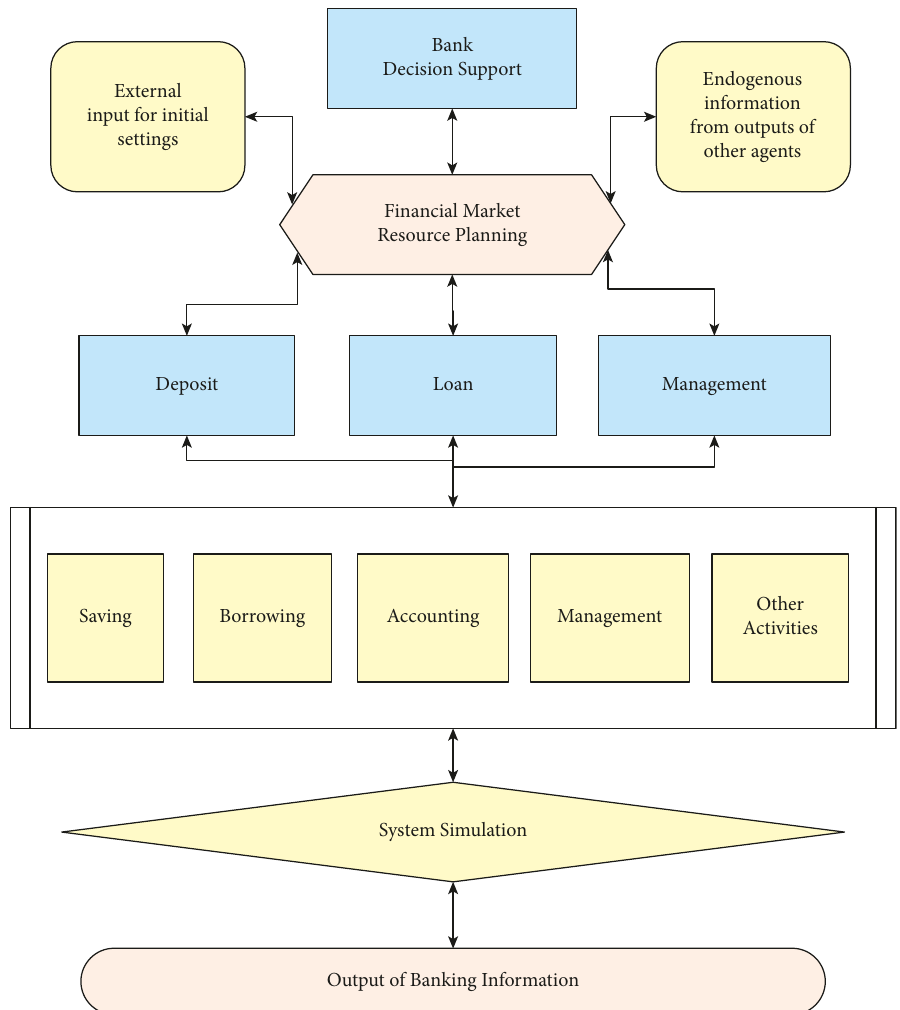
Figure 5: Overview of the process and structure of banking system (source: Guangzhou Milestone Software Co., Ltd.,